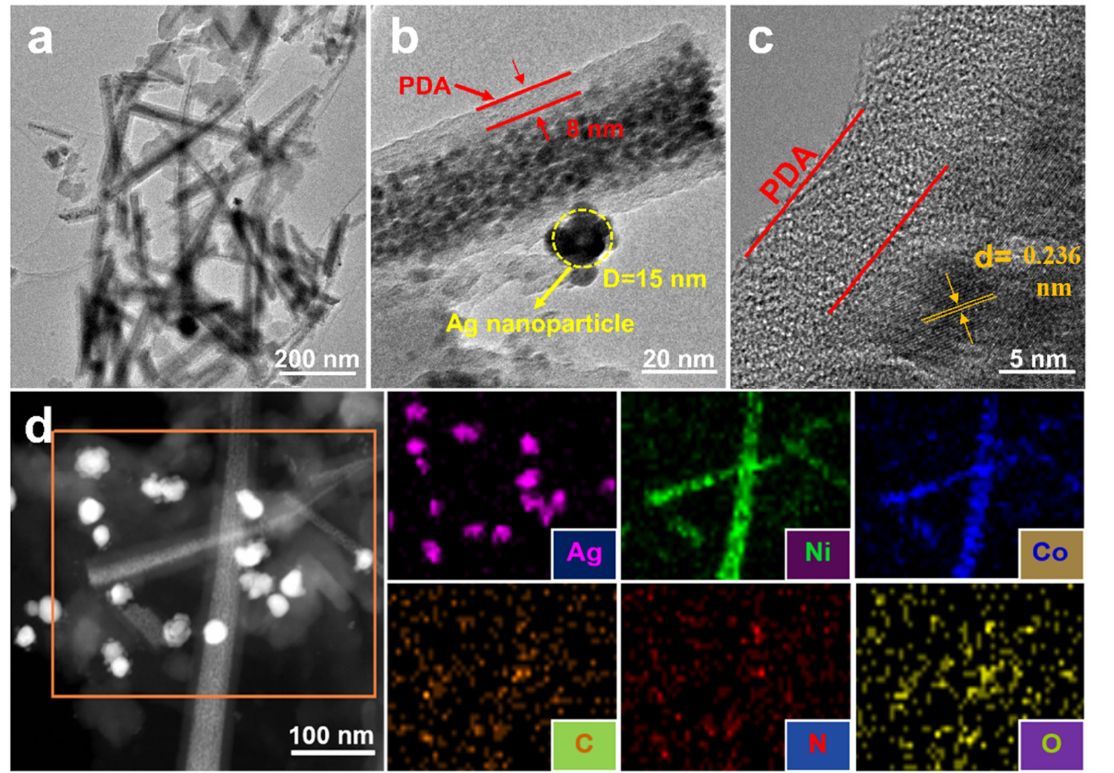
Figure 2. XRD patterns of samples of ( a ) NiCo 2 O 4 -NC and ( b ) Ag/NiCo 2 O 4 -NC.